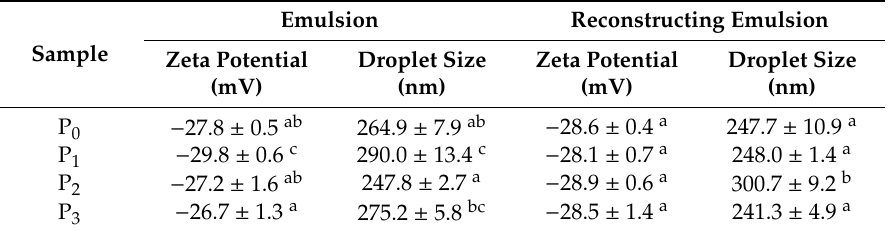
Table 2. Properties of emulsion and reconstructing